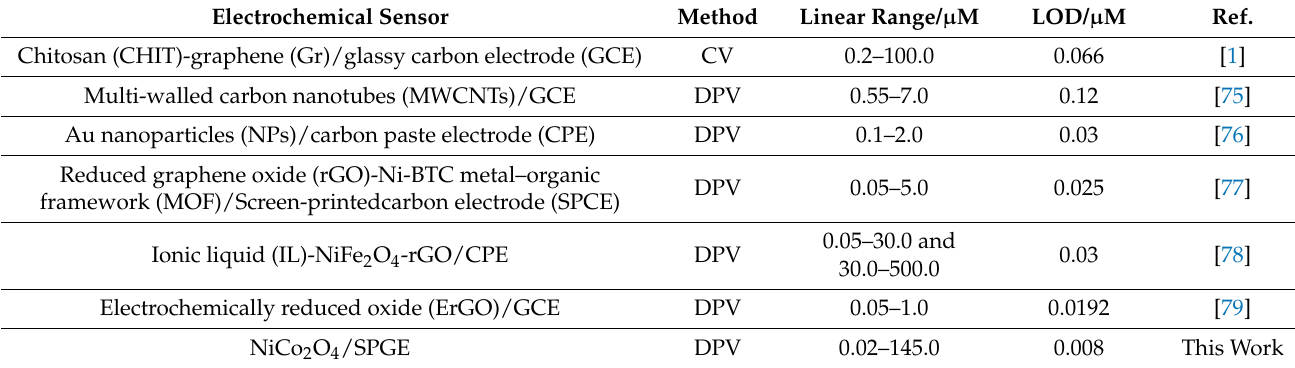
Table 1. Comparison of the efficiency of the NiCo 2 O 4 /SPGE with other reported modified electrodes for sunset yellow